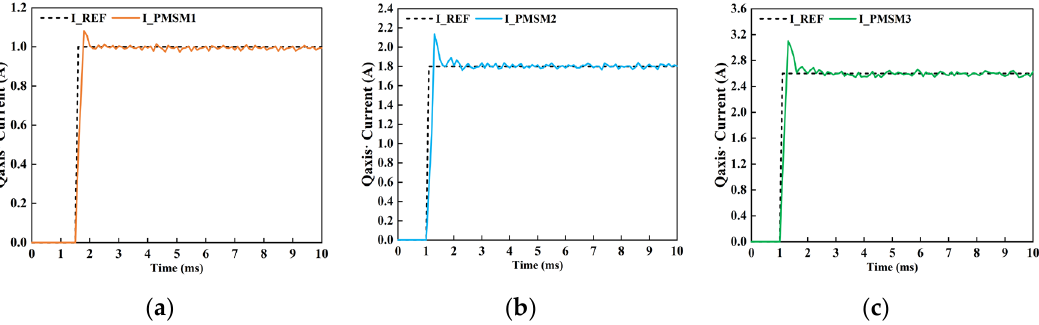
Figure 19. Schematic diagram of current response. ( a ) Current step response with step current 1 A; ( b ) current step response with step current 1.8 A; and ( c ) current step response with step current 2.6 A.